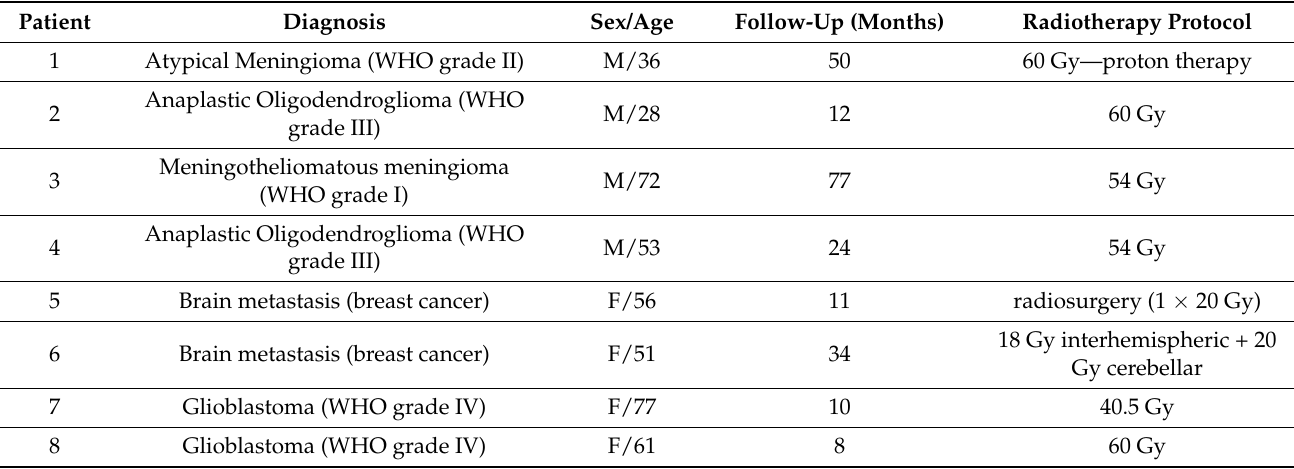
Table 1. Characteristics of the patient group with radiation necrosis. “Follow-up” refers to the time between completion of radiotherapy and the last follow-up scan, in which no progression of the disease was observed (Gy: Gray; GBM: Glioblastoma; WHO: World Health Organization; M/F: Male/Female).